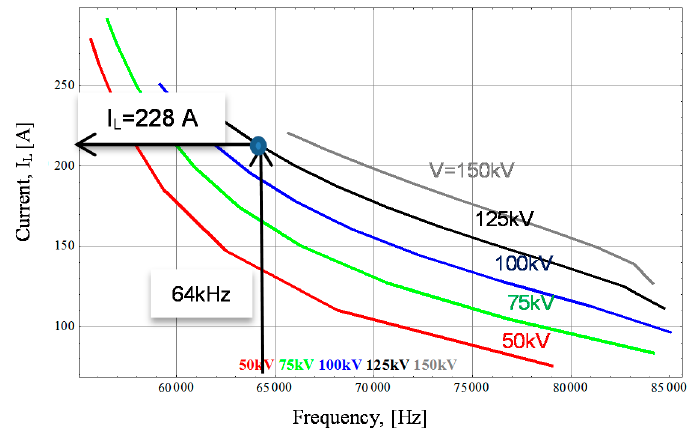
Figure 6. Resonant current I L versus output voltage and switching frequency at V i = 750 V.